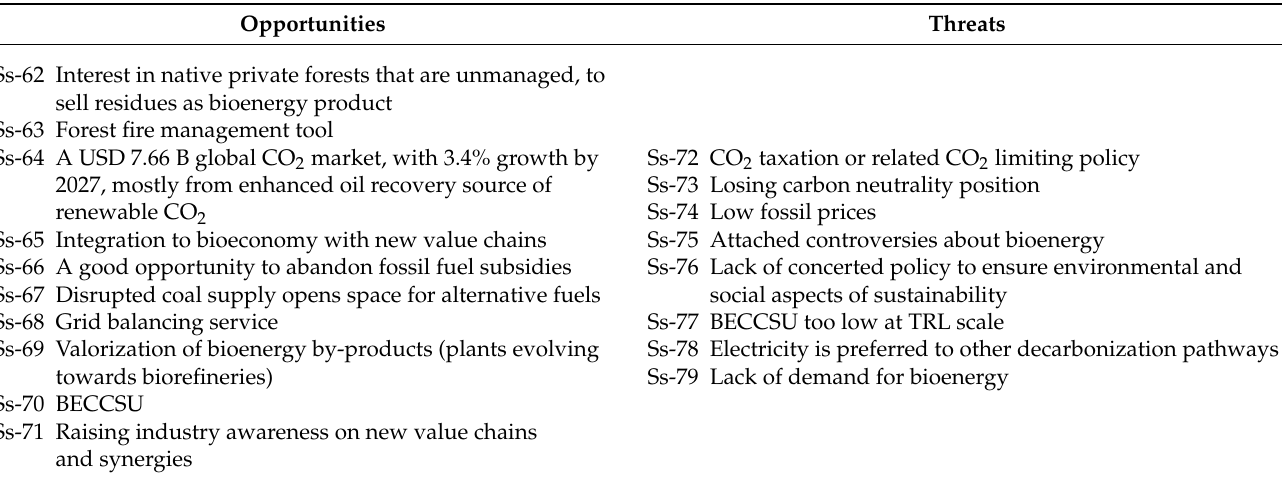
Table A4. Opportunities and Threats (SWOT) of biomass supply chains in respect to market demand for biomass.